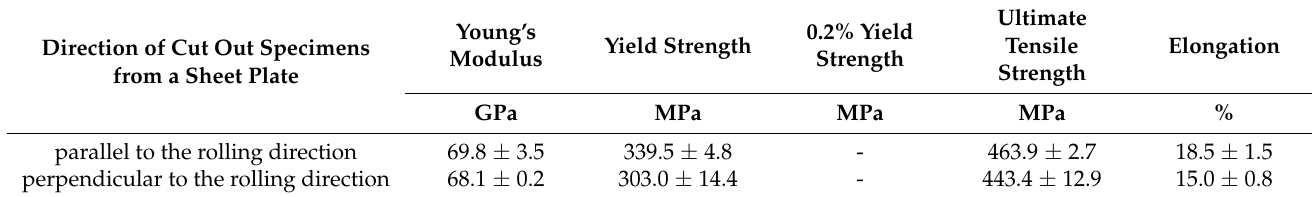
Table 6. Monotonic properties of the D16ATV aluminum alloy in the form of 1.13 mm thick sheet plate. Direction of Cut Out Specimens from a Sheet Plate parallel to the rolling direction perpendicular to the rolling direction Table 7. Monotonic properties of the D16CzATV aluminum alloy in the form of 1.11 mm thick sheet plate. Direction of Cut Out Specimens from a Sheet Plate parallel to the rolling direction perpendicular to the rolling direction Table 8. Monotonic properties of the D16UTV aluminum alloy in the form of 0.55 mm thick sheet plate. Direction of Cut Out Specimens from a Sheet Plate parallel to the rolling direction perpendicular to the rolling